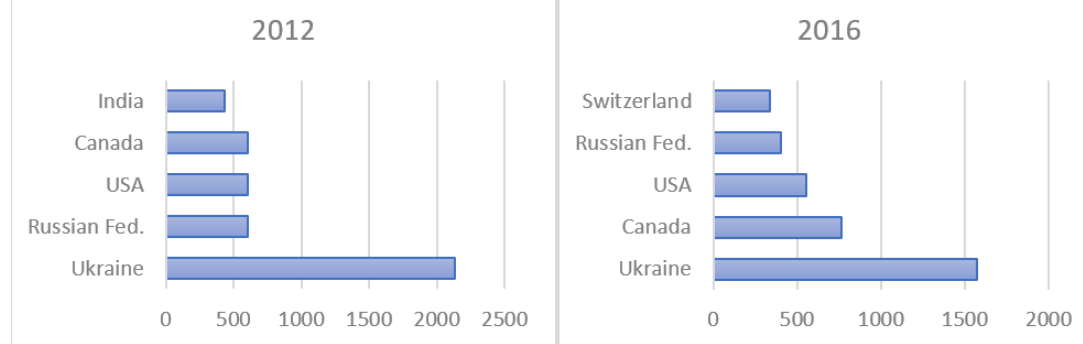
Figure 2. Main suppliers of cereals to the EU ($ mill). Source: Authors’ elaboration. Comtrade.